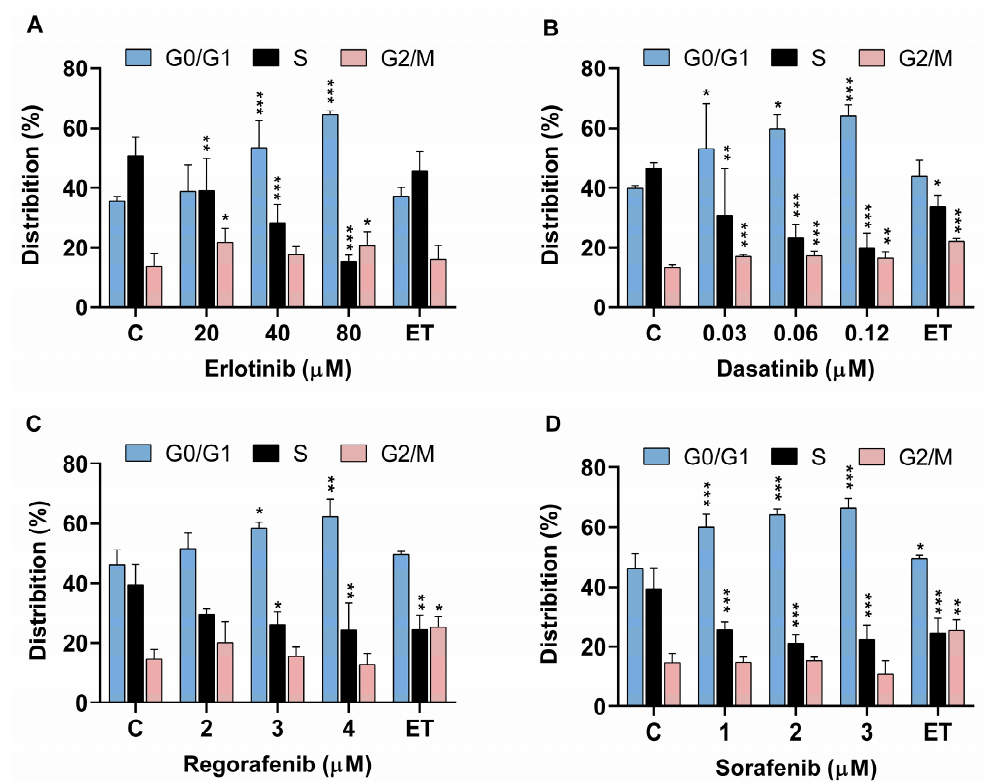
Figure 3. Flow cytometric analysis of cell cycle distribution of zebrafish liver cells (ZFL) after exposure to ( A ) erlotinib, ( B ) dasatinib, ( C ) regorafenib, ( D ) sorafenib for 72 h. ET (0.17 µ M) was used as a positive control. Three independent experiments were performed. Significant difference between untreated control cells ( C ) and cells exposed to TKIs and ET. * ( p < 0.05), ** ( p < 0.01), *** ( p < 0.001). Cell cycle arrest in the G0/G1 phase and a concomitant reduction in the number of